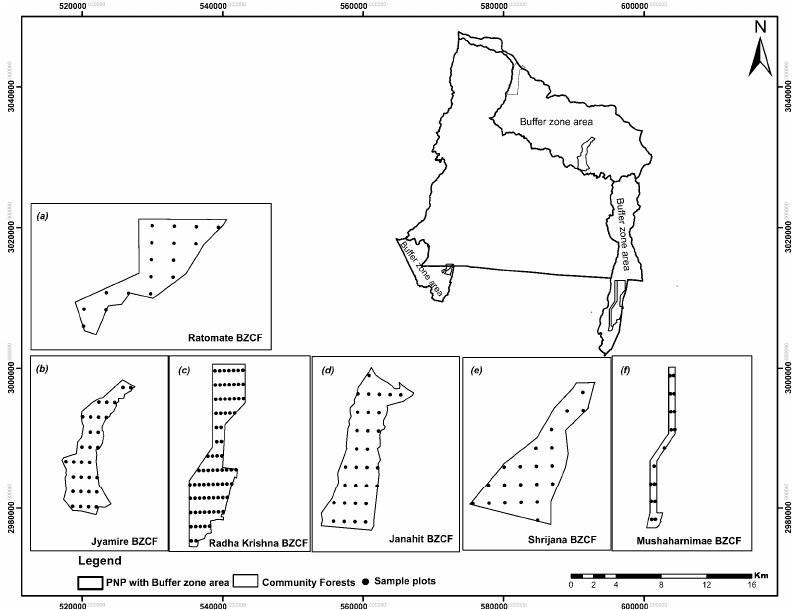
Figure 1. Study area map showing the Parsa National Park (PNP) with buffer zone community forests (BZCFs) and sample